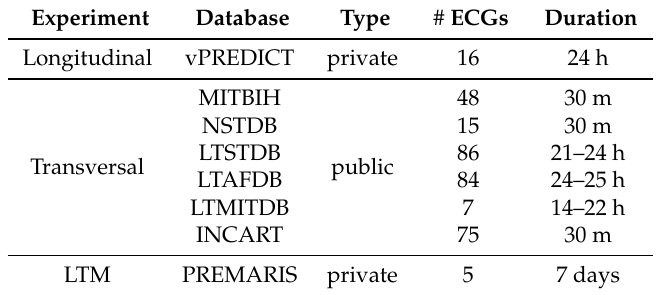
Table 1. Duration and number of ECGs used from different databases in this